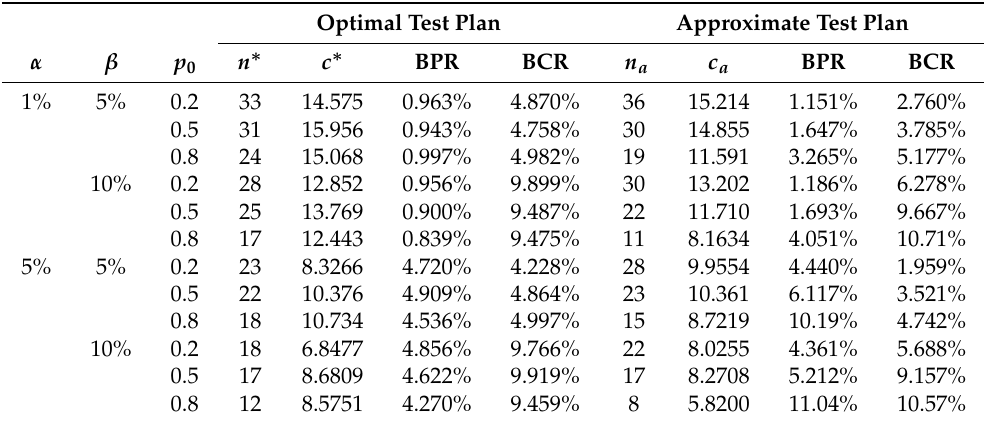
Table 1. Optimal and approximate plans, ( n ∗ , c ∗ ) and ( n a , c a ) , and the corresponding Bayesian risks, BPR and BCR, when ( λ 0 , d 0 ) = ( 0.3,0.8 ) and ( λ 1 , d 1 ) = ( 0.7,0.6 ) .